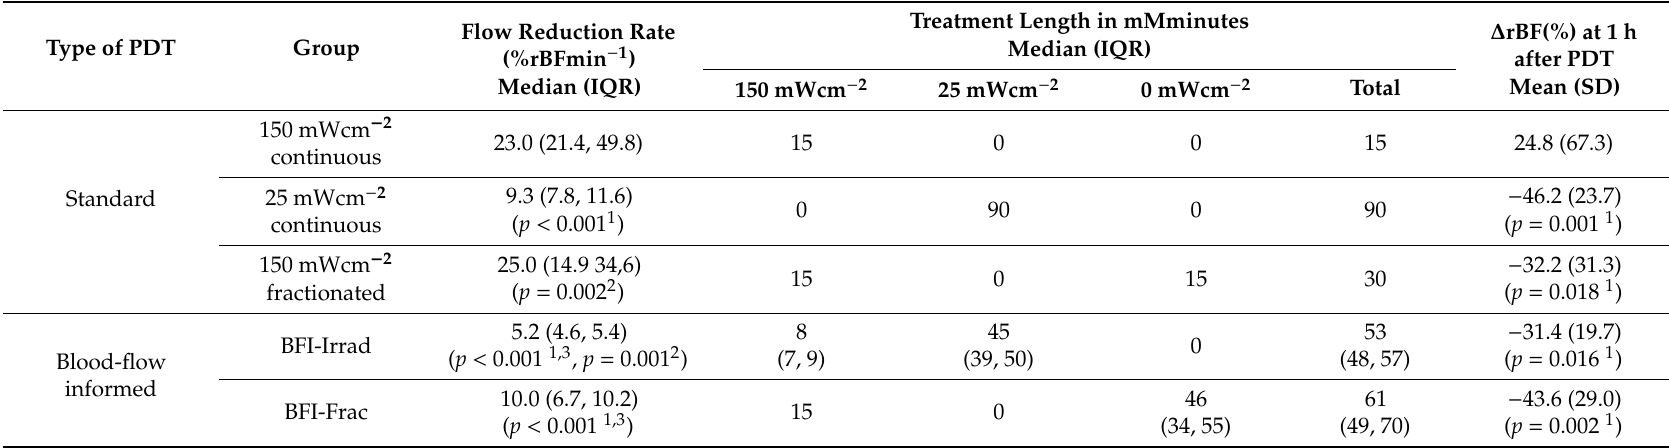
Table 1. For RIF tumors, flow reduction rate (overall flow reduction rate for BFI-Irrad and BFI-Frac), treatment length (segregated by time spent at each irradiance), and ∆ rBF at 1 h after illumination with standard or